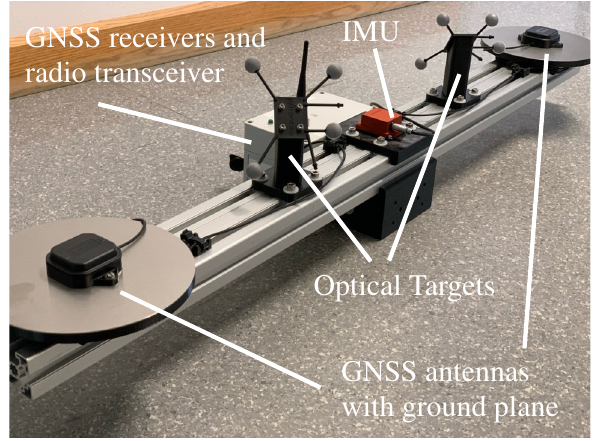
Figure 4. GNSS-INS navigation system with two multiband GNSS antennas and IMU. Correction data from the RTK base station is received via a long range radio transceiver. cross consisting of two perpendicular lines in the scene. The fan angle of the laser lines is 45 deg , which is reduced in water to approximately 32 deg . The lasers are fired synchronized to the camera shutter using trigger pulse signals. An alternating firing order of the individual lasers is employed, such that each image captured by the camera includes only one of the two laser lines. An example of the captured 3D point cloud is depicted in Fig.